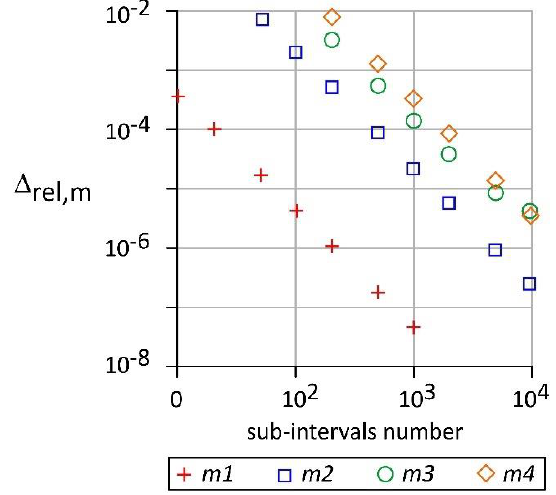
Figure 10. The relative error in determining the integrals for an approximation using the approximate method depending on the number of subintervals (the most unfavorable case of the received ones).